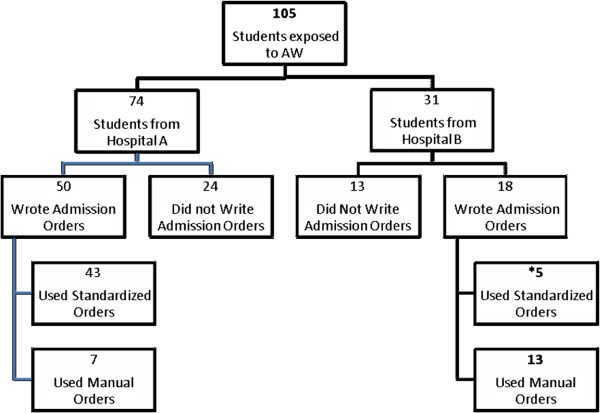
Flow sheet of students exposed to AW and use of CIWA-Ar orders by students from each hospital. *Student were identified as admitted to using order set at other hospital which were obtained from past exposure from previous elective rotations.